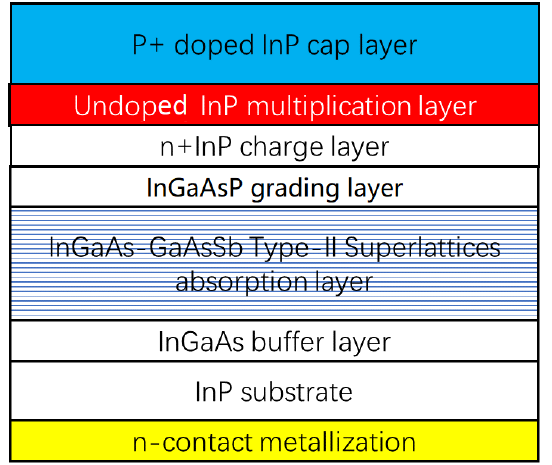
Figure 1. Diagram of the device layer structure.